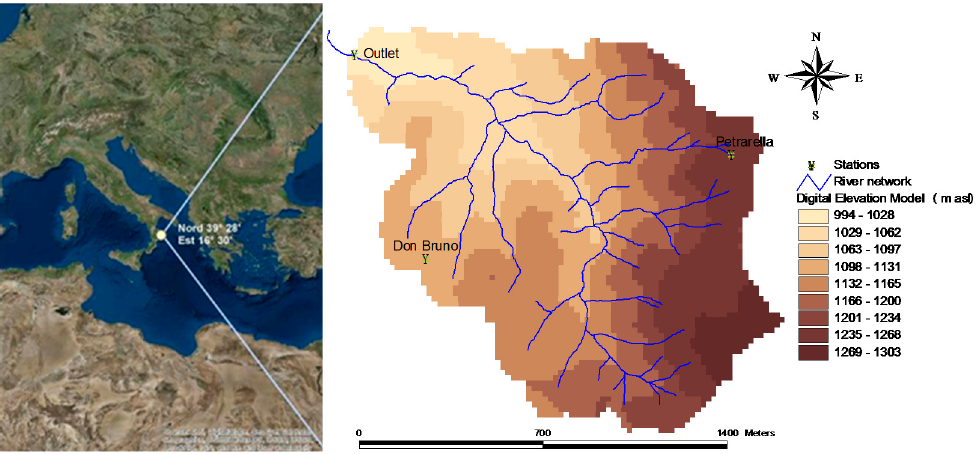
Figure 1. Digital elevation model of the Bonis basin with stations.